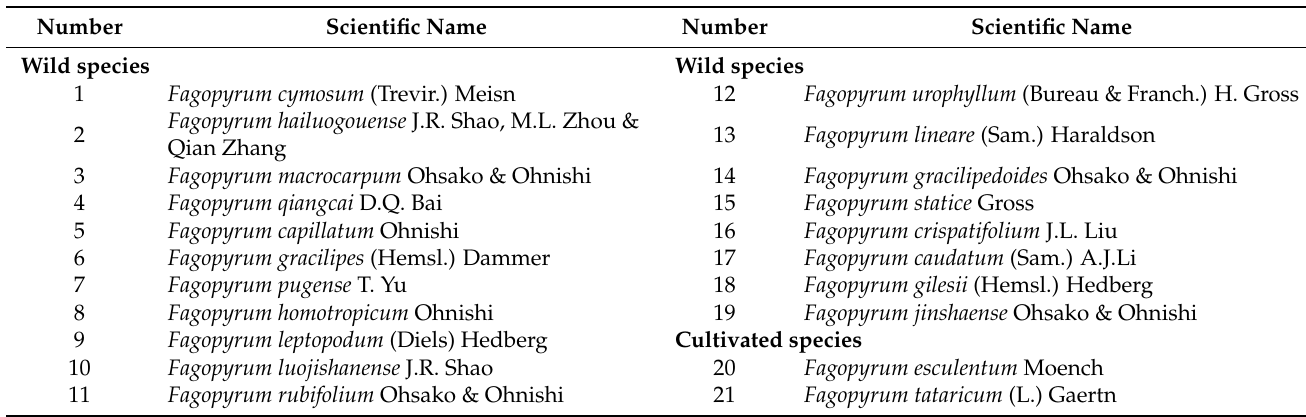
Table 1. The 21 species of genus